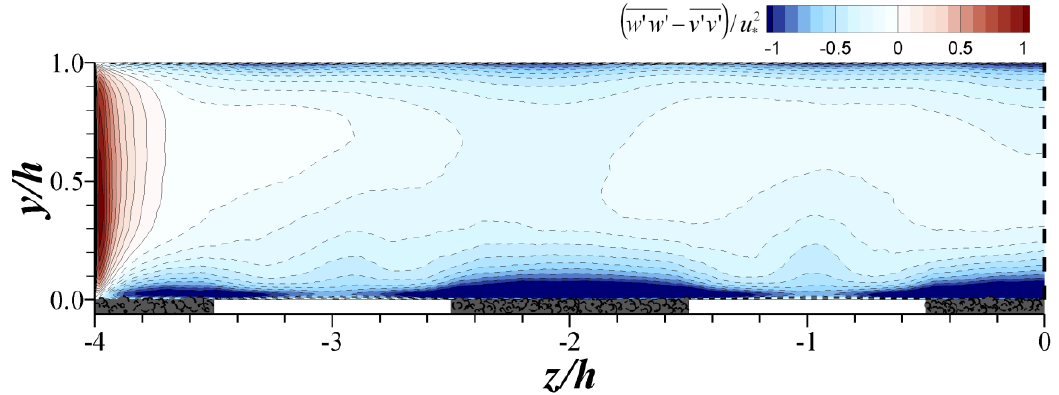
Figure 11. Contours of the normalized normal stress anisotropy in the left half of the